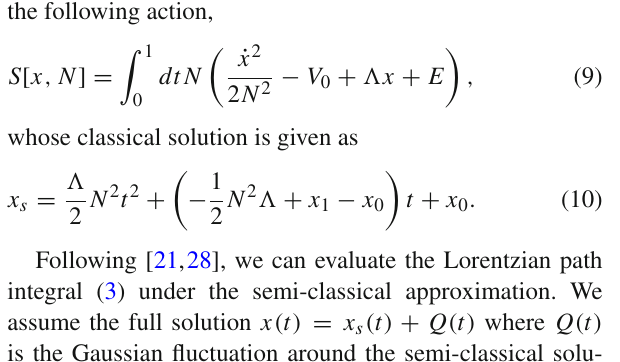
Fig. 1 These figures show the potential V ( x ) for the linear, harmonic oscillator, inverted harmonic oscillator, and double well models. In this paper, we consider the Lorentzian path integral for these